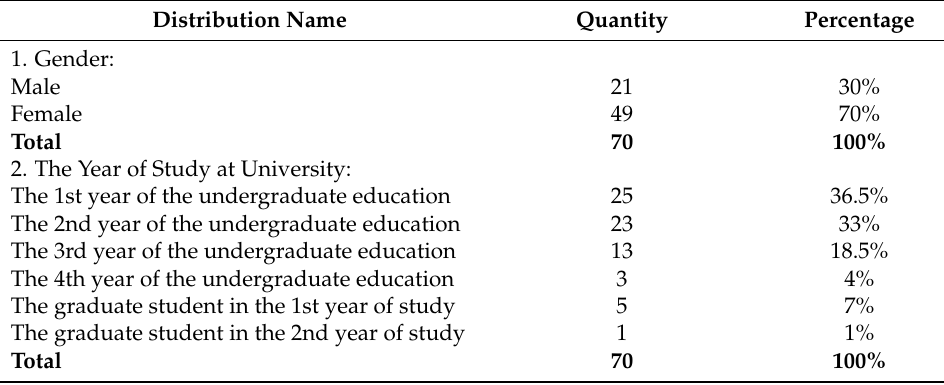
Table 3. Demographic Characteristics of